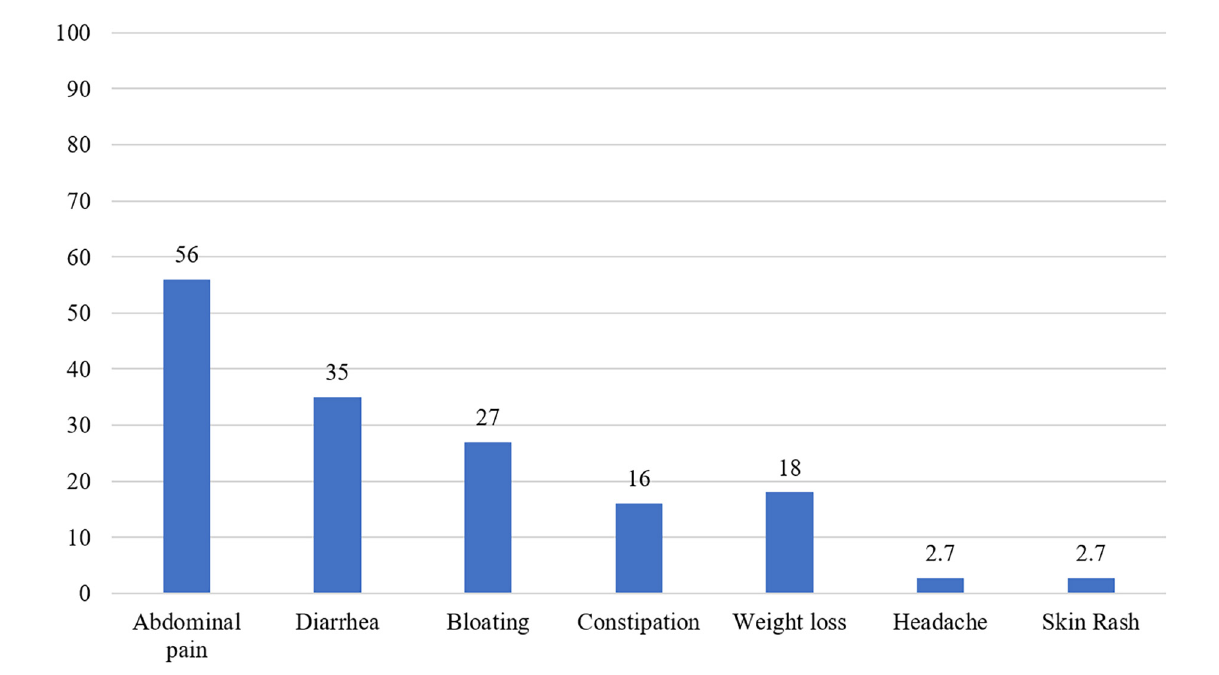
Frontiers in Nutrition